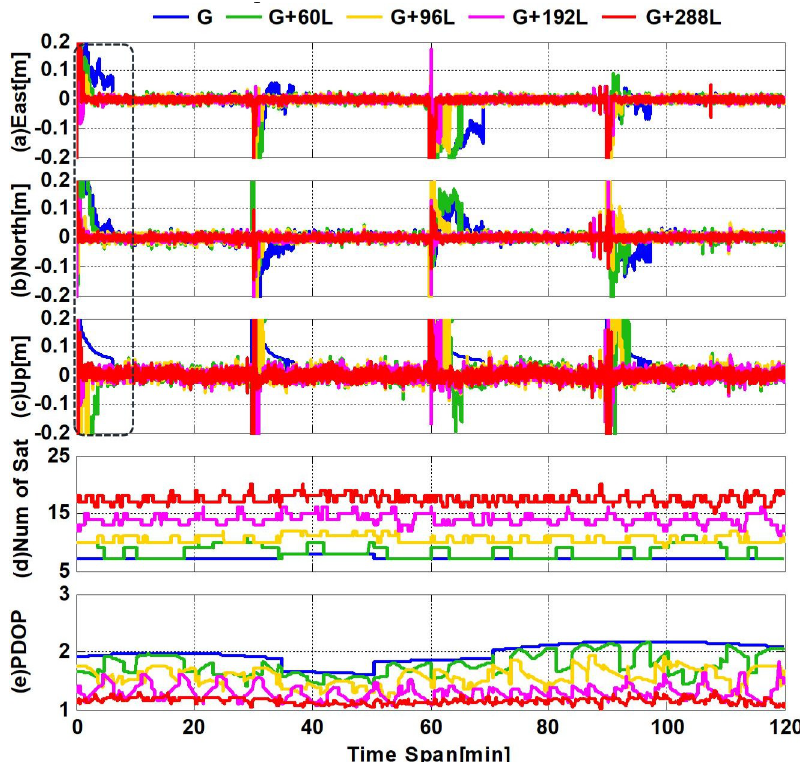
Figure 3. Comparisons of different scales of LEO constellations augmented GPS RTK solutions in east, north, and up components, respectively, for ‘P339-P341′ baseline scheme. The visible satellite numbers and position dilution of precision (PDOP) values are also presented.